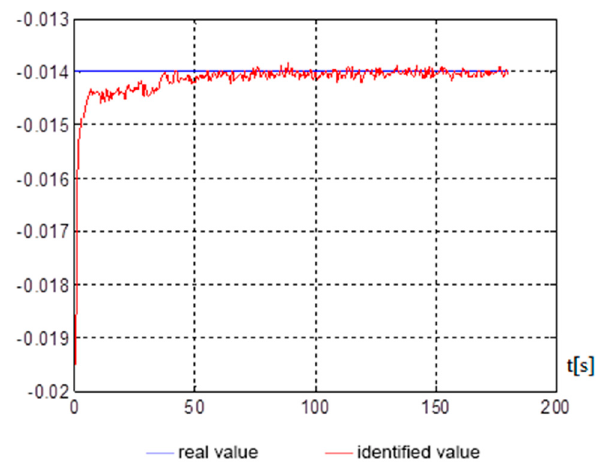
Figure 7. 0 x С assessment over time.